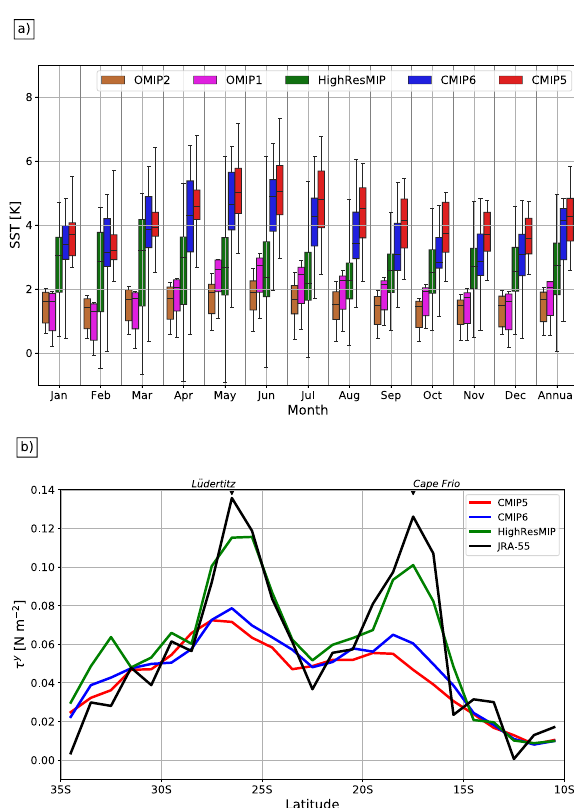
Fig. 2 Coastal SST bias and alongshore meridional wind stress. a Climatological coastal SST bias relative to OISST (in ∘ C), zonally averaged over a 2 ∘ wide band along the coast in the SETA region. The horizontal bar within each box represents the median and the length of each vertical bar the quartiles. The extent of the whiskers shows the minimum and maximum values within each MMM, and the last column represents the yearly average. b Time-mean (1985 – 2004) alongshore (grid cells closest to the coast) meridional wind stress for all MMMs and JRA-55, the atmospheric reanalysis used to force the uncoupled OMIP2 ocean models. The black triangles at the top show the location of Cape Frio (17 ∘ S – 18 ∘ S) and L € u deritz (26 ∘ S – 27 ∘